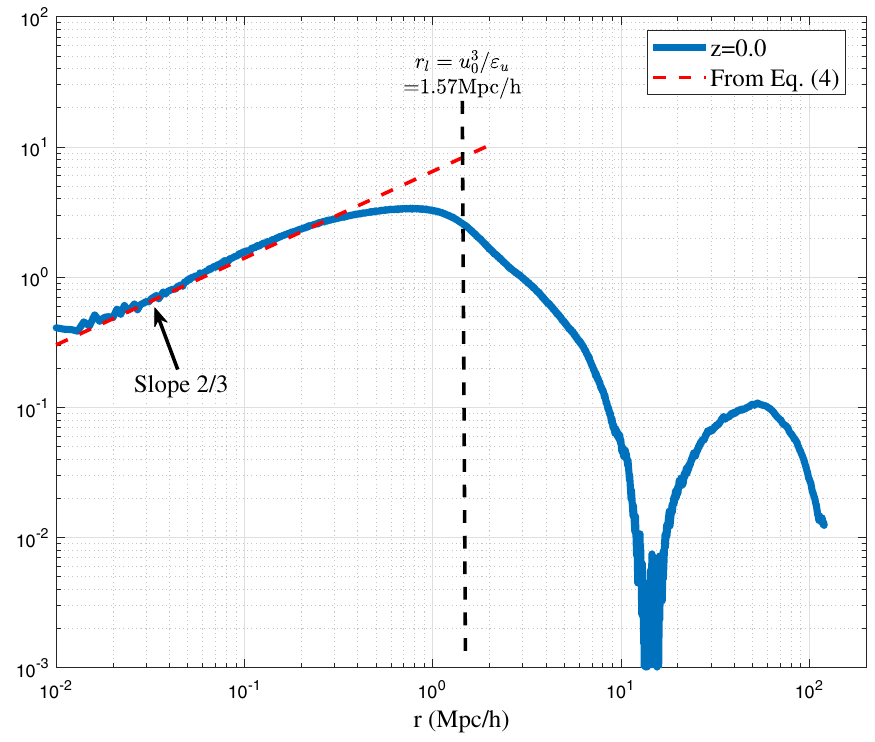
lp 2 ( r ) with comoving scale r at z=0. 2 ε u ) 2 / 3 r 2 / 3 can be ( . A two-thirds law, i.e. ∝ − u 3 0 /ε u , where inverse energy cascade is established = −